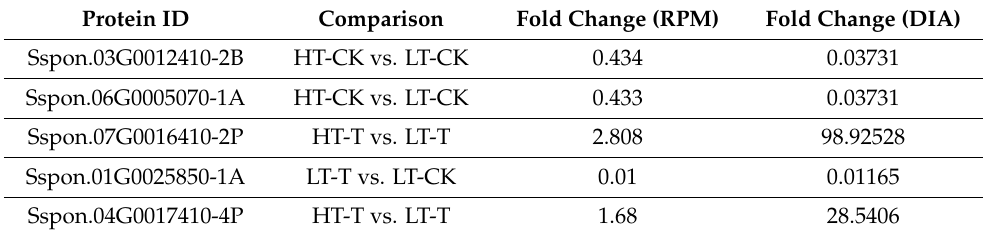
Table 2. PRM verification of